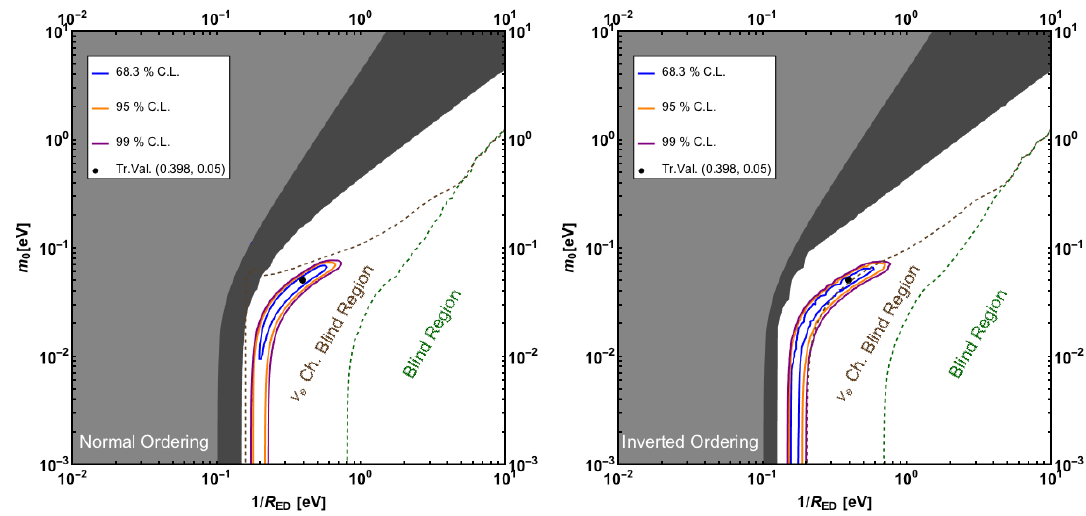
Figure 3 . Left (right) panel: allowed regions for the ‘true’ LED parameters m 0 = 0 : 05 eV and 1 =R ED = 0 : 398 eV and assuming as test model the LED scenario for normal (inverted) ordering. All the other oscillation parameters were (cid:12)xed to their best (cid:12)t values. The dashed green (dashed brown) curve shows the SBN sensitivity to both muon disappearance and electron appearance channel (only electron appearance channel). The region denoted by Blind region ( (cid:23) e Ch. Blind region ) is the region with no sensitivity to the muon neutrino disappearance (electron neutrino